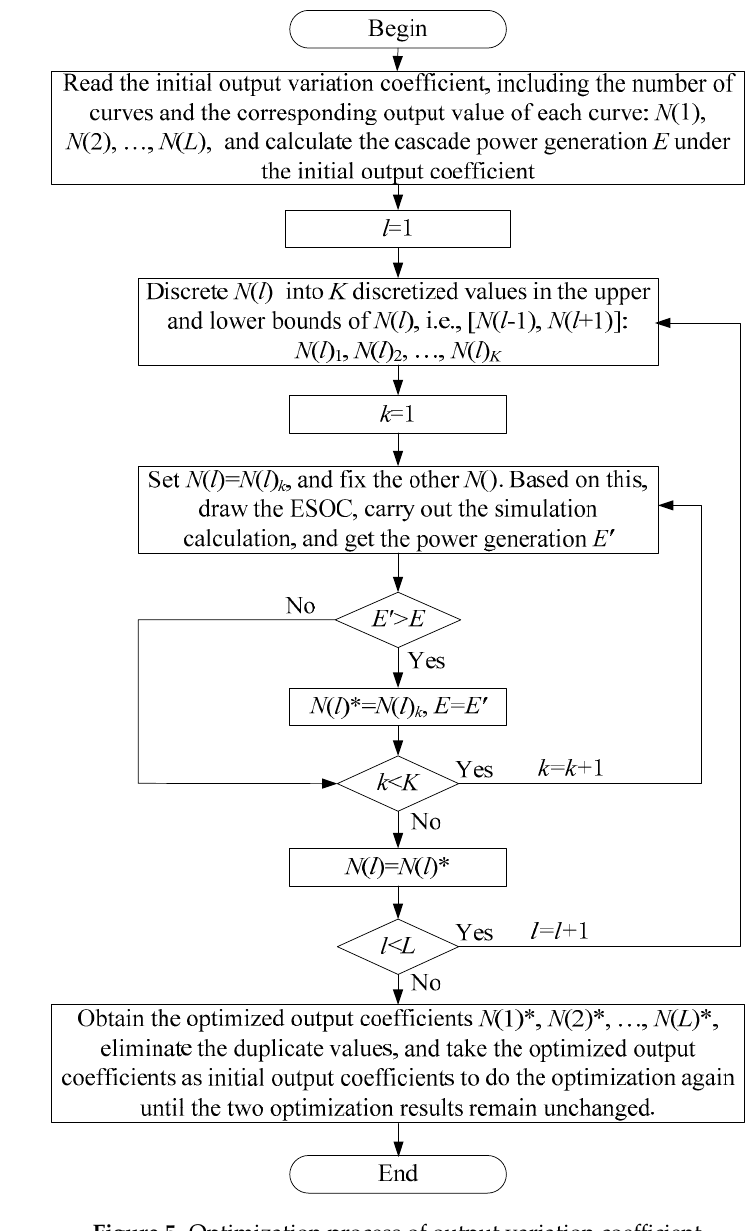
Figure 5. Optimization process of output variation coefficient.